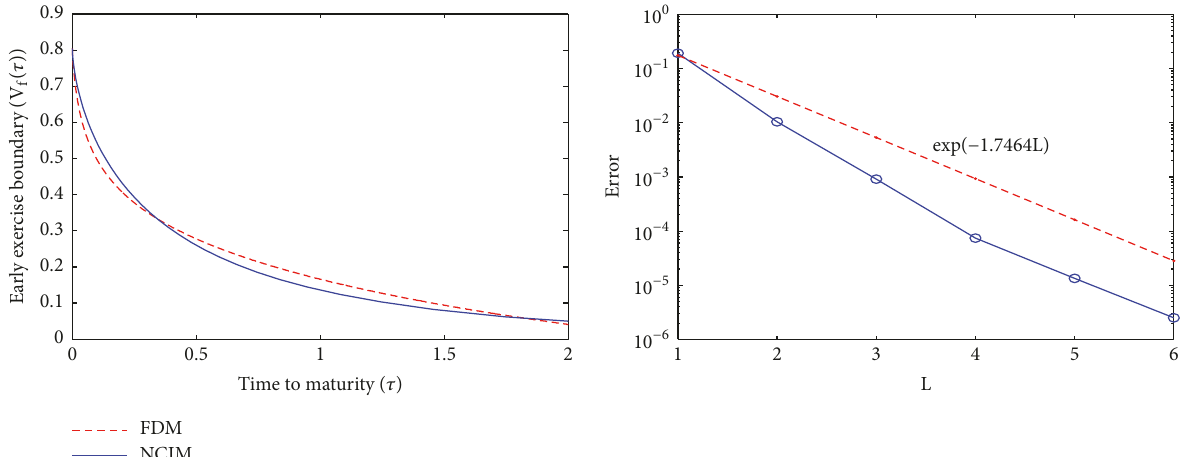
Figure 3: Early exercise boundaries (left) under MRGP model with 𝑇/2000 for FDM and 𝐿 = 6 for NCIM, NCIM errors in log-scale versus 𝐿 (right).